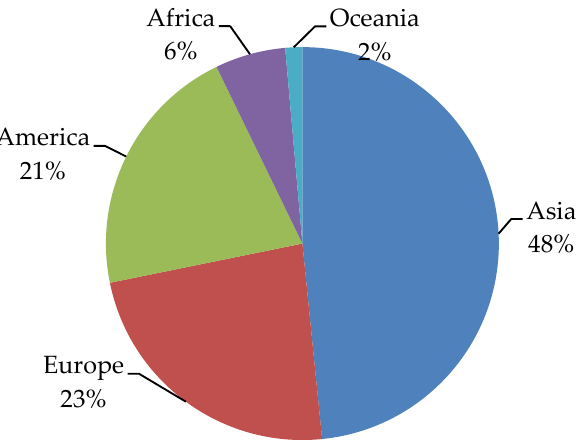
Figure 5. Worldwide cancer incidence. Data collected from GLOBOCAN (2018) [2].